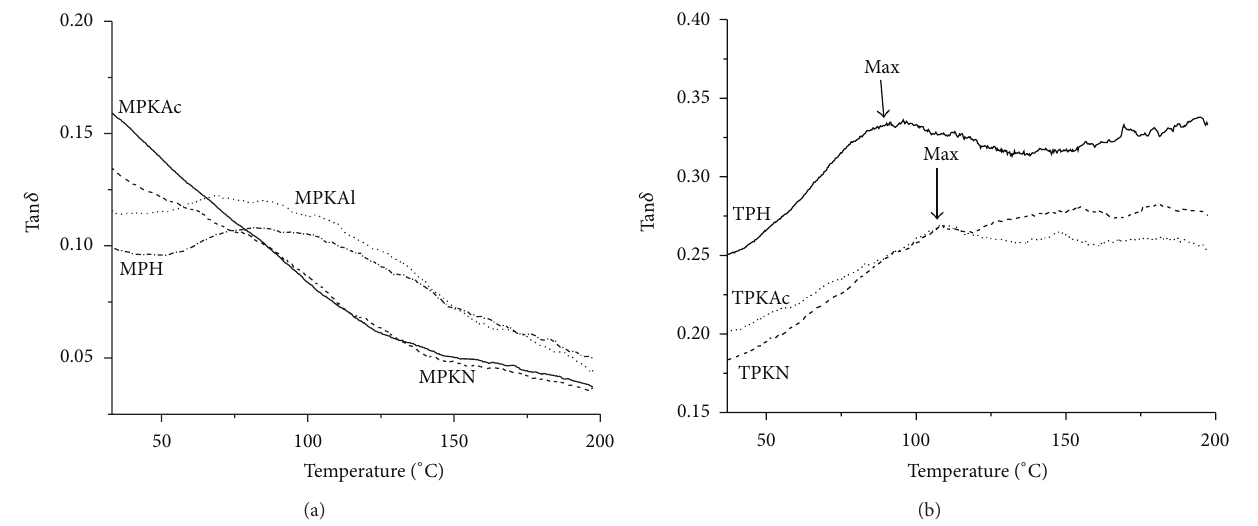
Figure 6: Tangent 𝛿 of PU-keratin membranes; (a) for MDI and (b) for TDI.